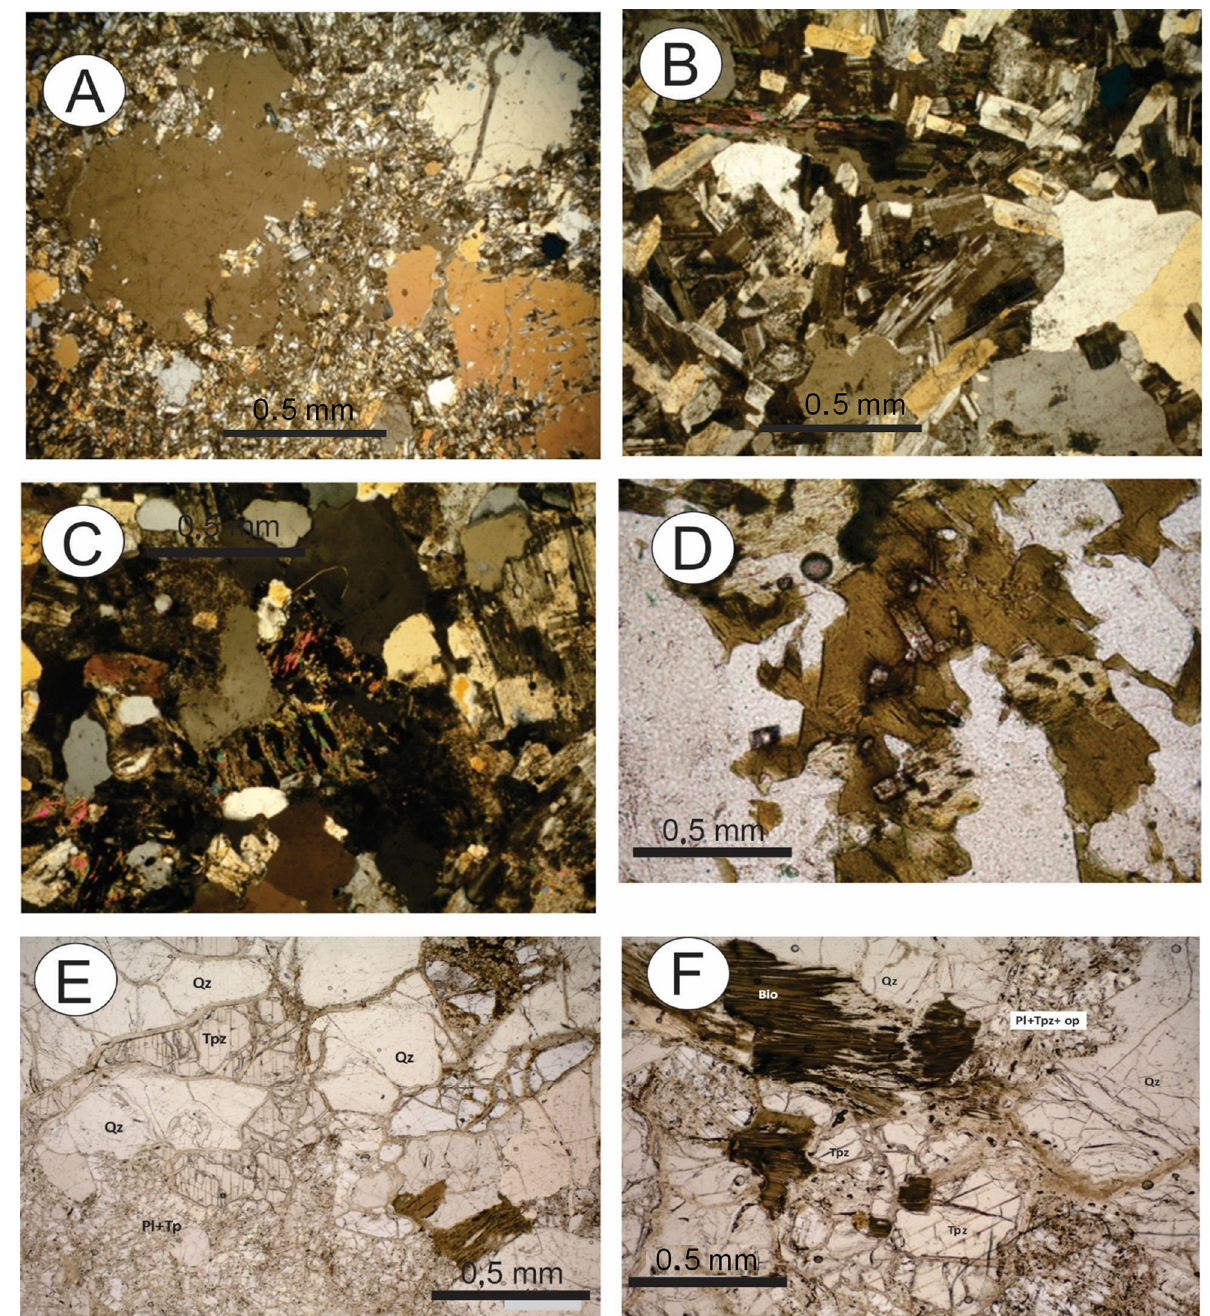
Figure 9. Macroscopic aspect of Endogreisen A characterized by mineralized medium-grained biotite-granites that make up the S ã o Domingos Region. ( A ) medium biotite-granite with green to brown biotite grains; intensely perthitized K-feldspar, interstitial plagioclase; and ( B ) development of round quartz crystals. ( C ) Microscopic feature of fine alkali-granite with albite, quartz, and micas associated with mafic minerals; ( D ) Albite-granite with larger quartz crystals and lath-shaped subhedral plagioclase crystals, with a characteristic twin of albite changing from orthoclase to sericite; ( E ) zinnwaldite-albite granite showing opaque with zinnwaldite; ( F ) zinnwaldite grains with reaction with topaz an, quartz and plagioclase.